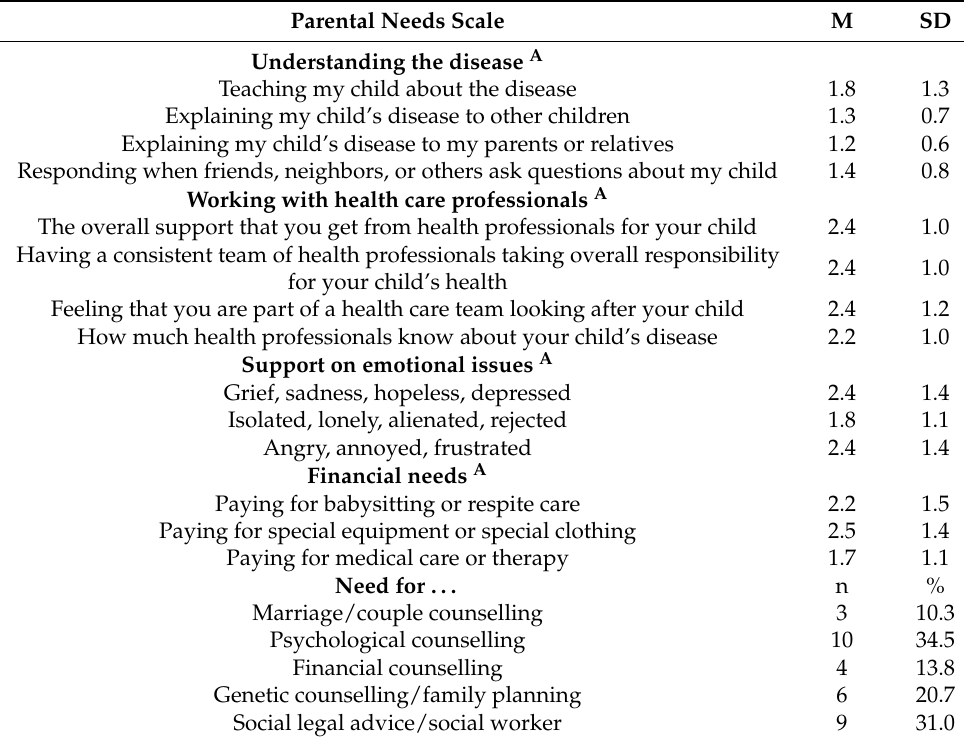
Table 4. Parental needs in families with children with SMA, total n =